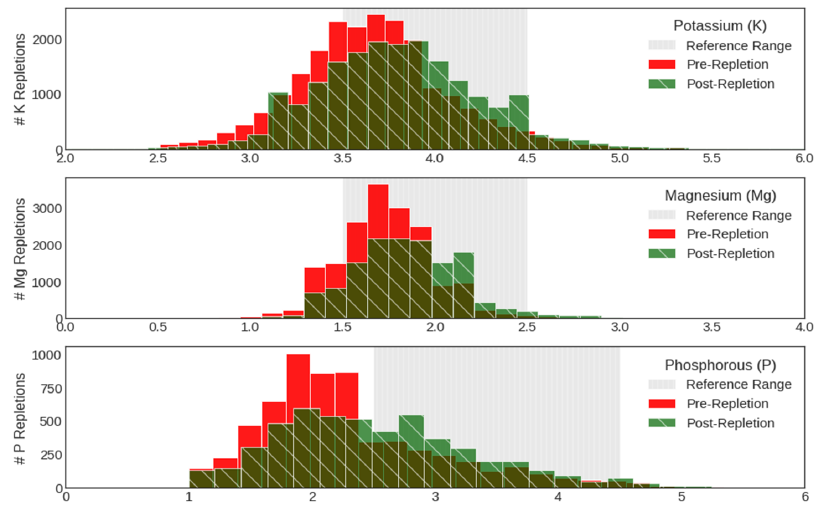
Figure 2. Distribution of electrolyte levels as executed by providers in historical dataset representing pre-repletion (red) and post-repletion events (green), along with the target range of electrolyte levels, in gray.